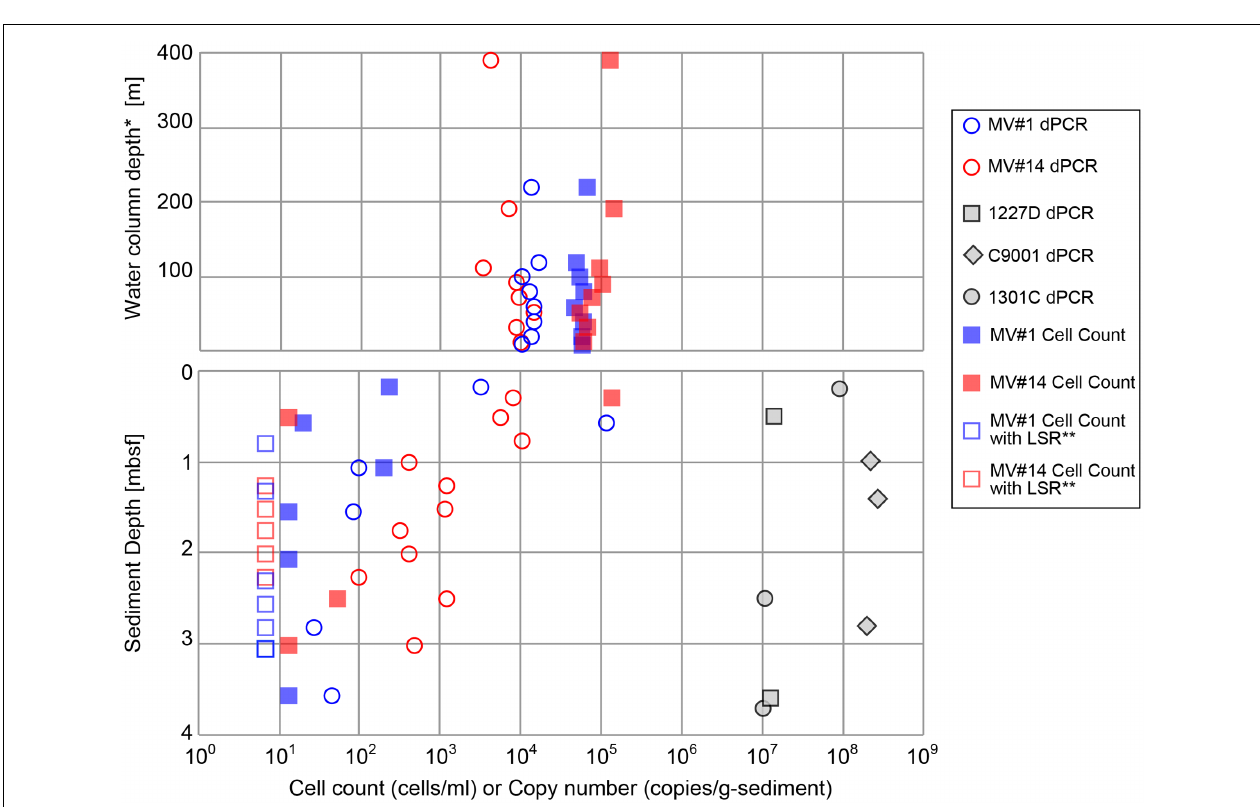
FIGURE 2 | Methane (red circles) and sulfate (blue circles) concentrations in sediment pore water at SMVs MV#1 (A) and MV#14 (B) .